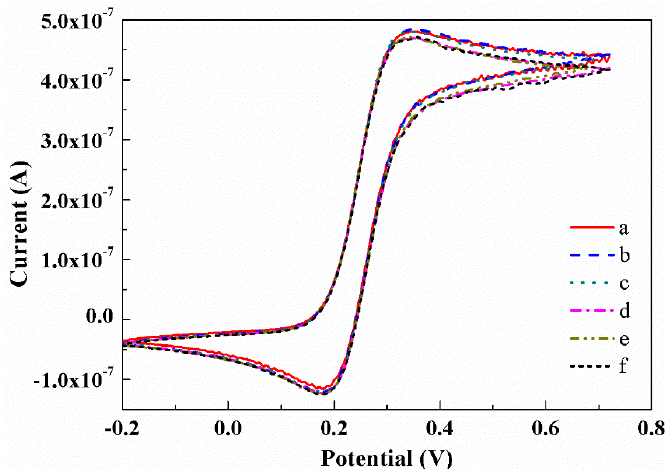
Figure 9. Cyclic voltammograms of the CNTs/CFME in a 5.0 mM K 4 Fe(CN) 6 (in 1.0 M KCl) at a scan rate of 0.01 V·s − 1 . ( a ) the first; ( b ) the tenth; ( c ) the twentieth; ( d ) the first after 104 days; ( e ) the tenth after 104 days; ( f ) the twentieth after 104 days.